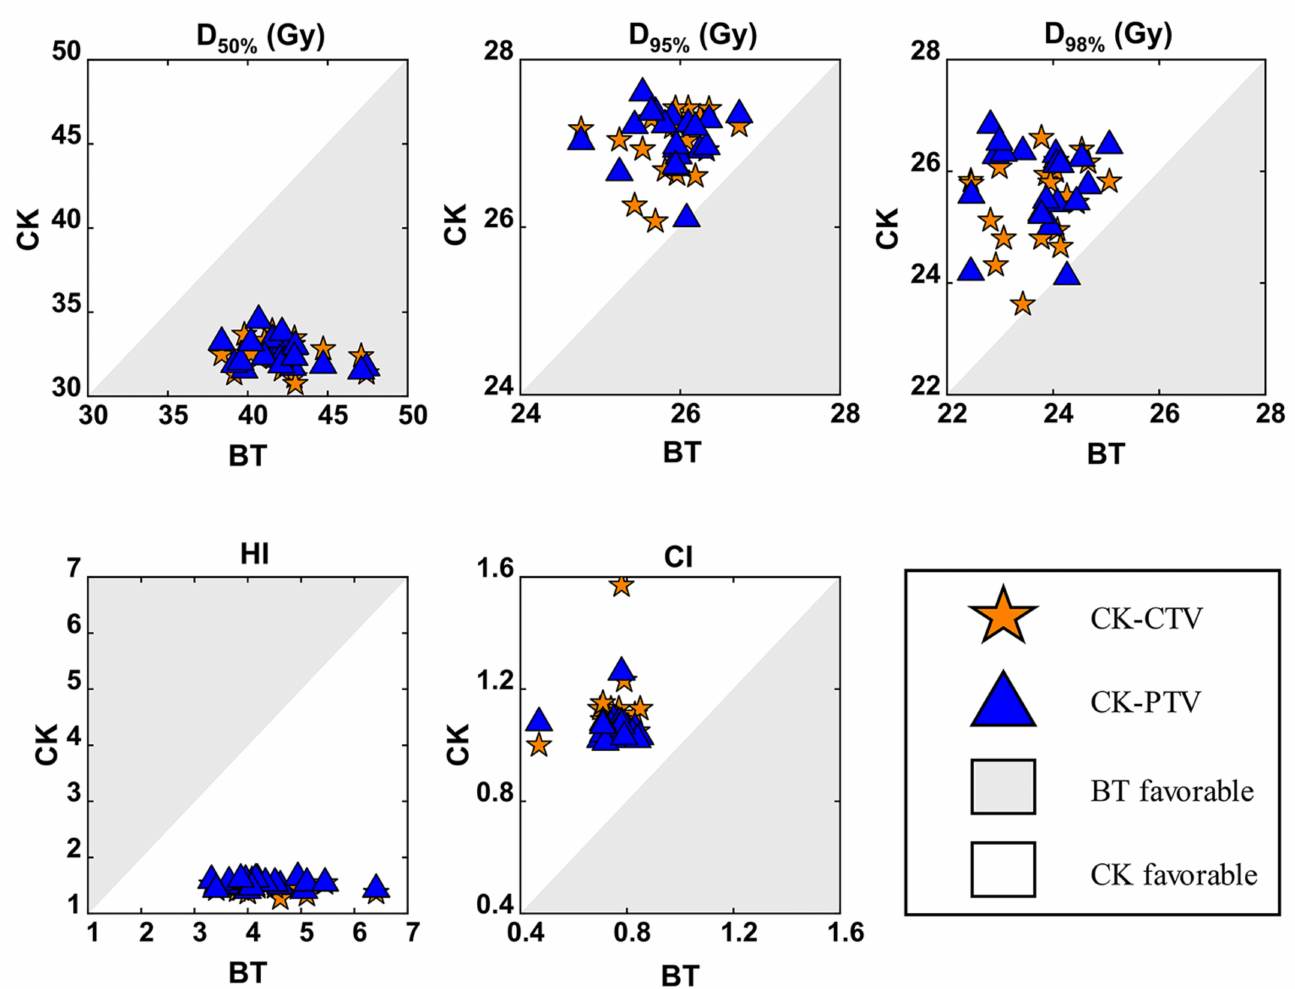
Figure 2. Comparisons of the BT, CK-CTV and CK-PTV plans by target volume dosimetric parameters. For every patient, each parameter is associated with three values (from the BT plan, CK-CTV plan and CK-PTV plan). In each graph, for example that of CI, each patient will contribute a pair of symbols, i.e., a star and a triangle; the star is plotted by the coordinates CI BT , CI CK-CTV , while the triangle is plotted by CI BT , CI CK-PTV . A symbol falling in the gray area implies the parameter is favorable in the BT plan. A symbol falling in the white area implies the parameter is favorable in the CK